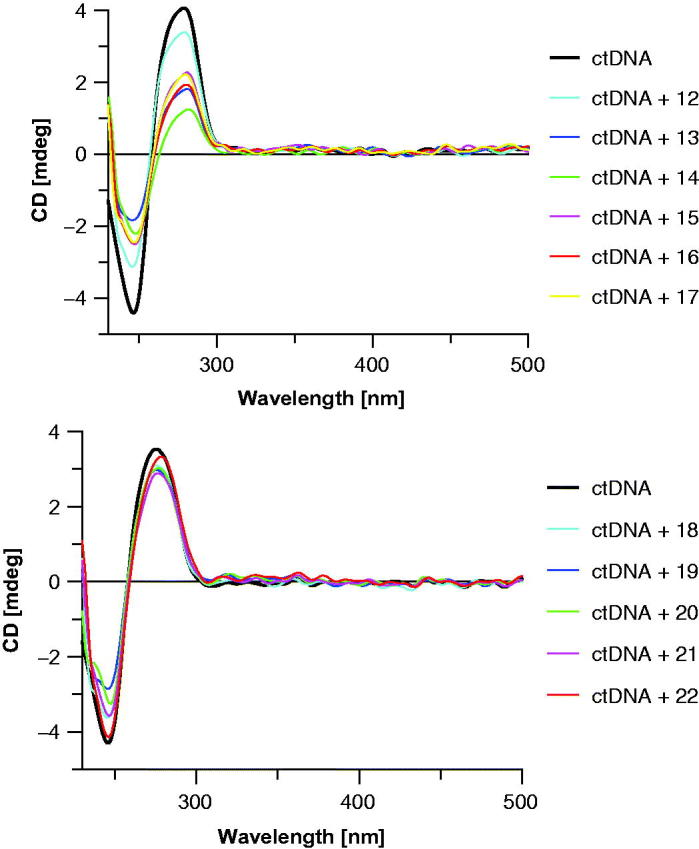
CD spectrum of ctDNA (black line, 7.46 µM) in the absence and in the presence of studied 7-MEOTA-THA heterodimers 12–22 (color lines, 0.3 mM) in 10 mM Tris–HCl buffer (pH 7.4).